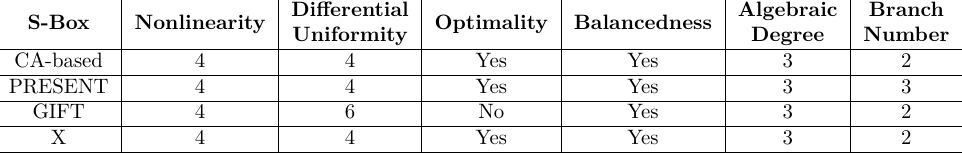
Table 2: Cryptographic properties of the considered S-boxes. All the properties listed here corresponding to the Skinny, Piccolo, Noekeon, Midori, and Prince S-Boxes are the same, and we represent all of them by the symbol